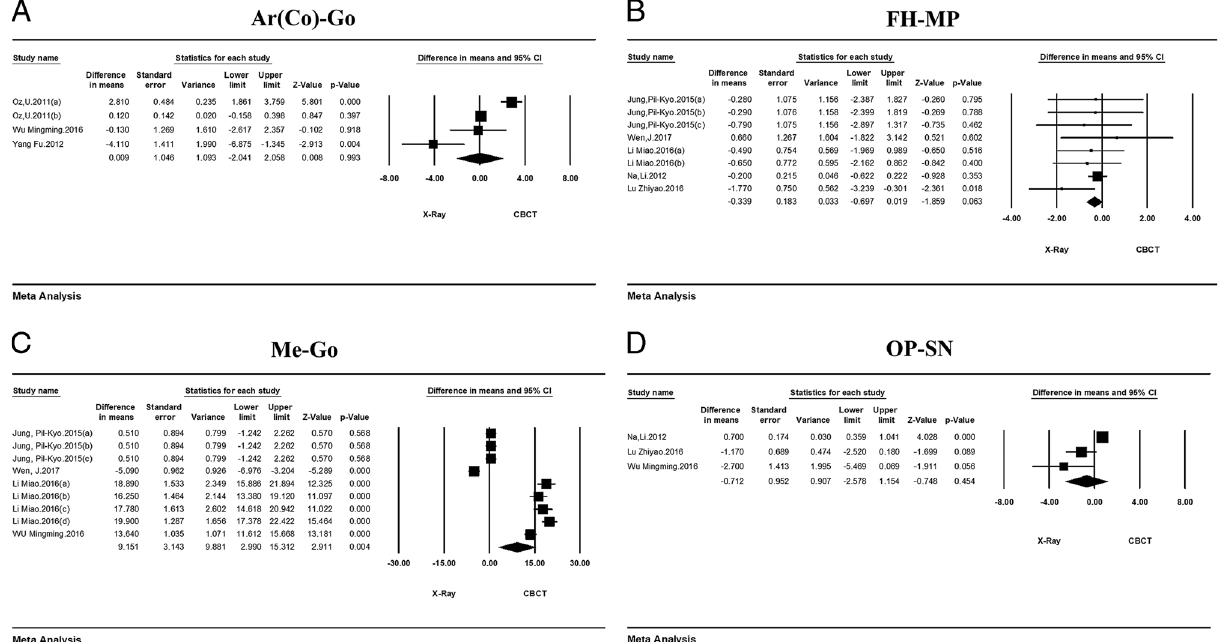
Figure 5. Forest plots of pooled DM for the CBCT group versus the X-ray group (A) Ar(Co)-Go, (B) FH-MP, (C) Me-Go, (D) OP-SN.